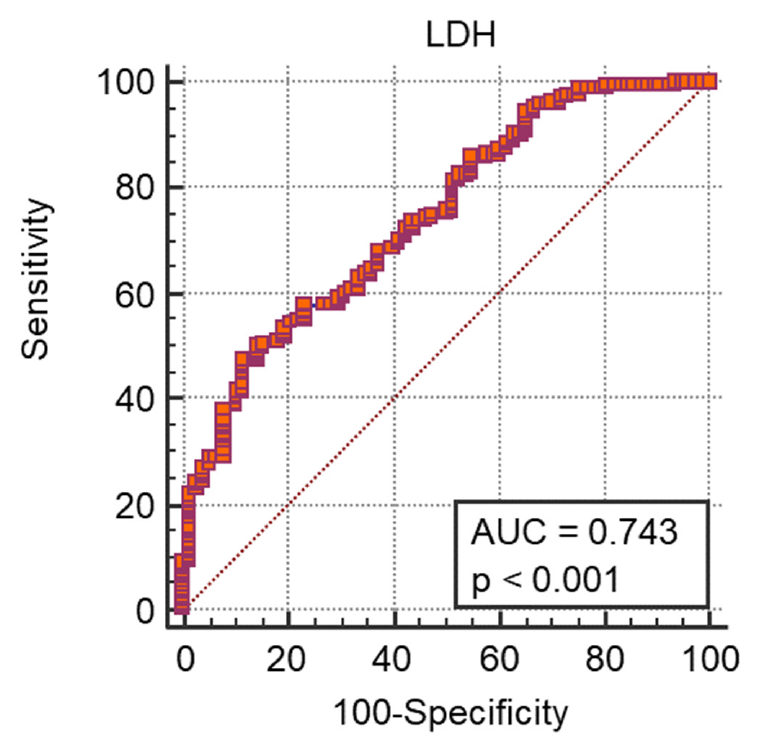
Figure 1. ROC curve e AUC values for LDH and ICU admission.